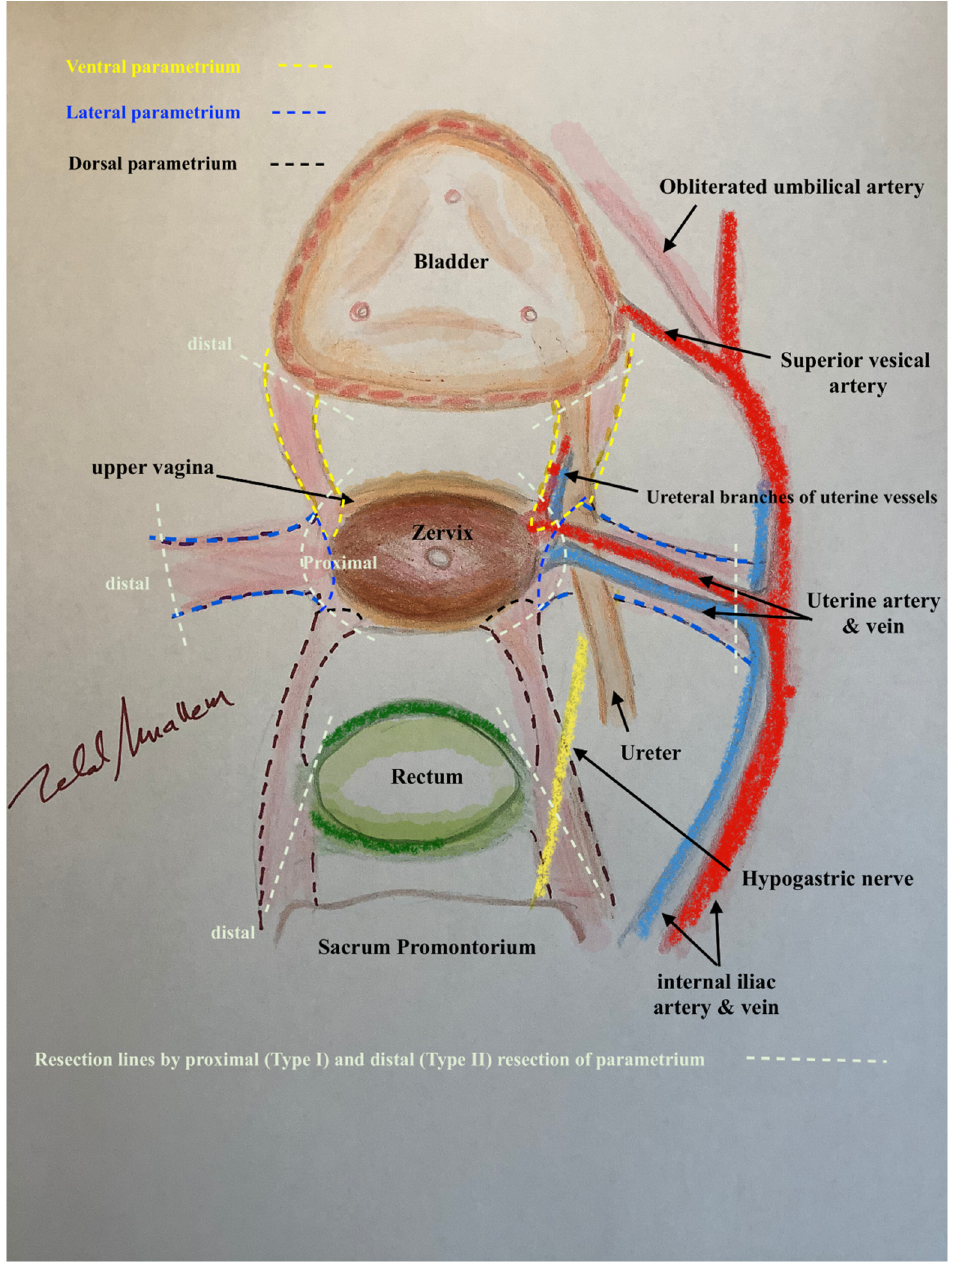
Figure 3. The three-dimentional parametrium in a cross-section of midpelvis with the explanation of distal and proximal aspects of ventral, lateral and dorsal parametrium and the resulted type I and type II radical hysterectomy.